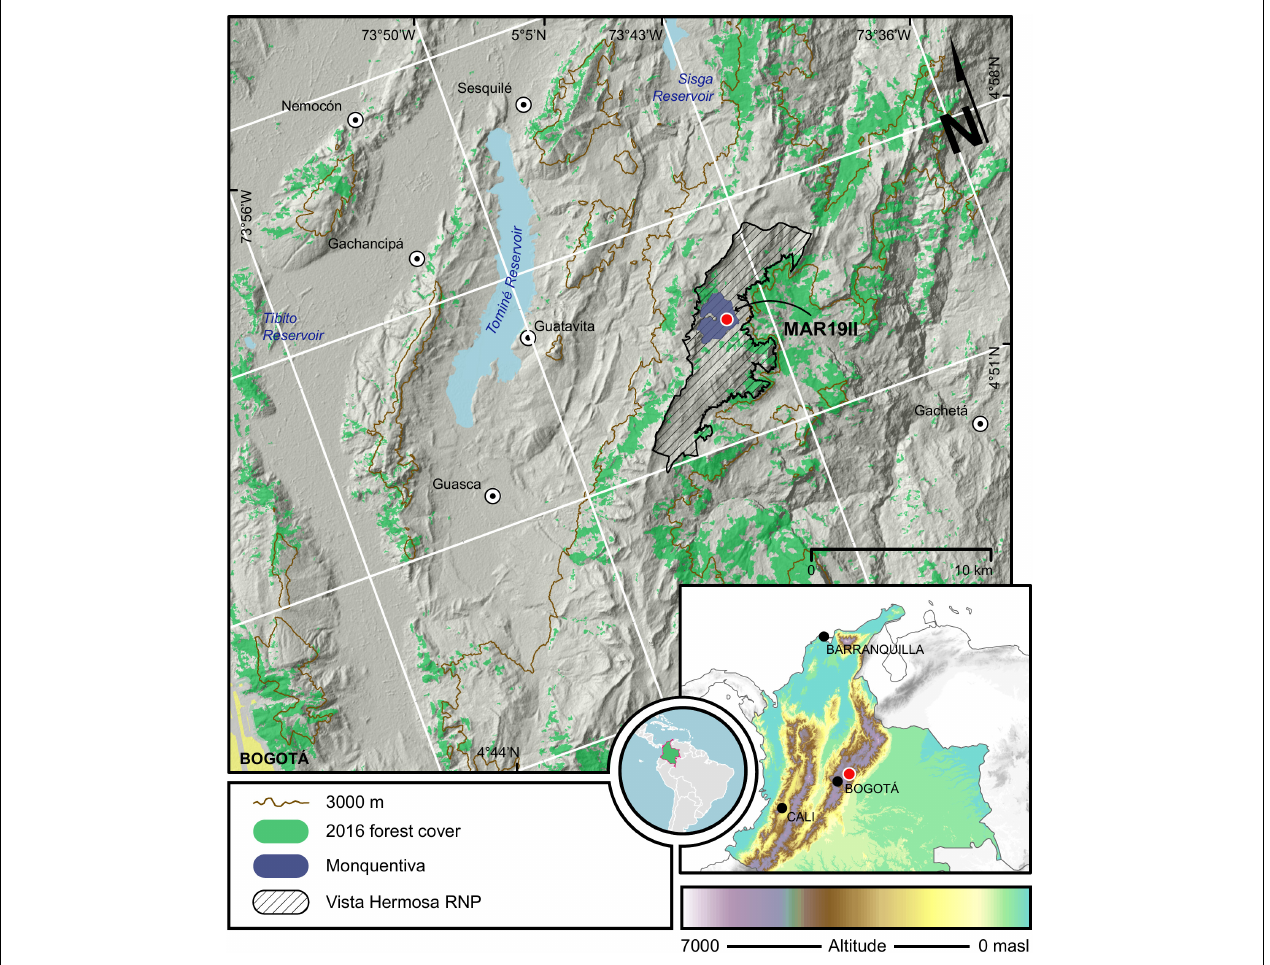
FIGURE 1 | Map showing the location of Monquentiva on the eastern flank of the Colombian Cordillera Oriental (CCO) and within the Vista Hermosa Regional Natural Park (RNP). The red dot indicates the location of coring sites MAR19-II and MAR19-G1 collected next to each other from the center of the peatbog. Green patches show the current distribution of the High Andean Forest (IDEAM,